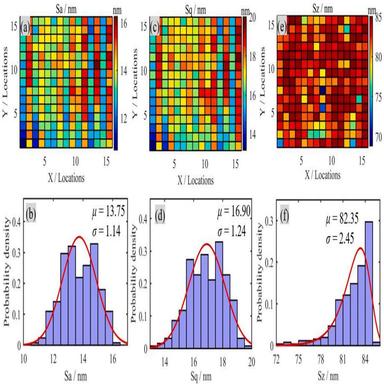
Surface texture parameters of different subarea scales at the machining conditions II of: Sa - (a) the calculated values and (b) the probability distributions, Sq - (c) the calculated values and (d) the probability distributions, and Sz - (e) the calculated values and (f) the probability distributions.